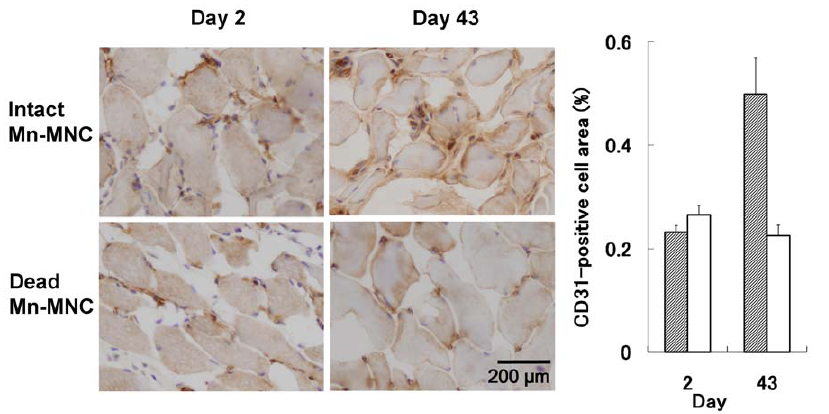
Figure 6. Immunohistochemistry for CD31. Both intact and dead Mn-MNC implanted sites were stained with CD31 at 2 and 43 days. Necrotic myofibers and neutrophilic infiltration induced by hindlimb ischemia were observed in both the intact and dead Mn-MNCs implanted sites at day 2. The bar graph indicates the fraction of the total area covered by CD31-positive cells (brown) of the intact (shaded) and dead (white) Mn-labeled transplanted MNCs. The areas coevered by CD31-positive cells in the intact Mn-MNCs implanted site at 43 days was larger than that at 2 days or in the dead Mn-MNCs implanted site at 43 days.